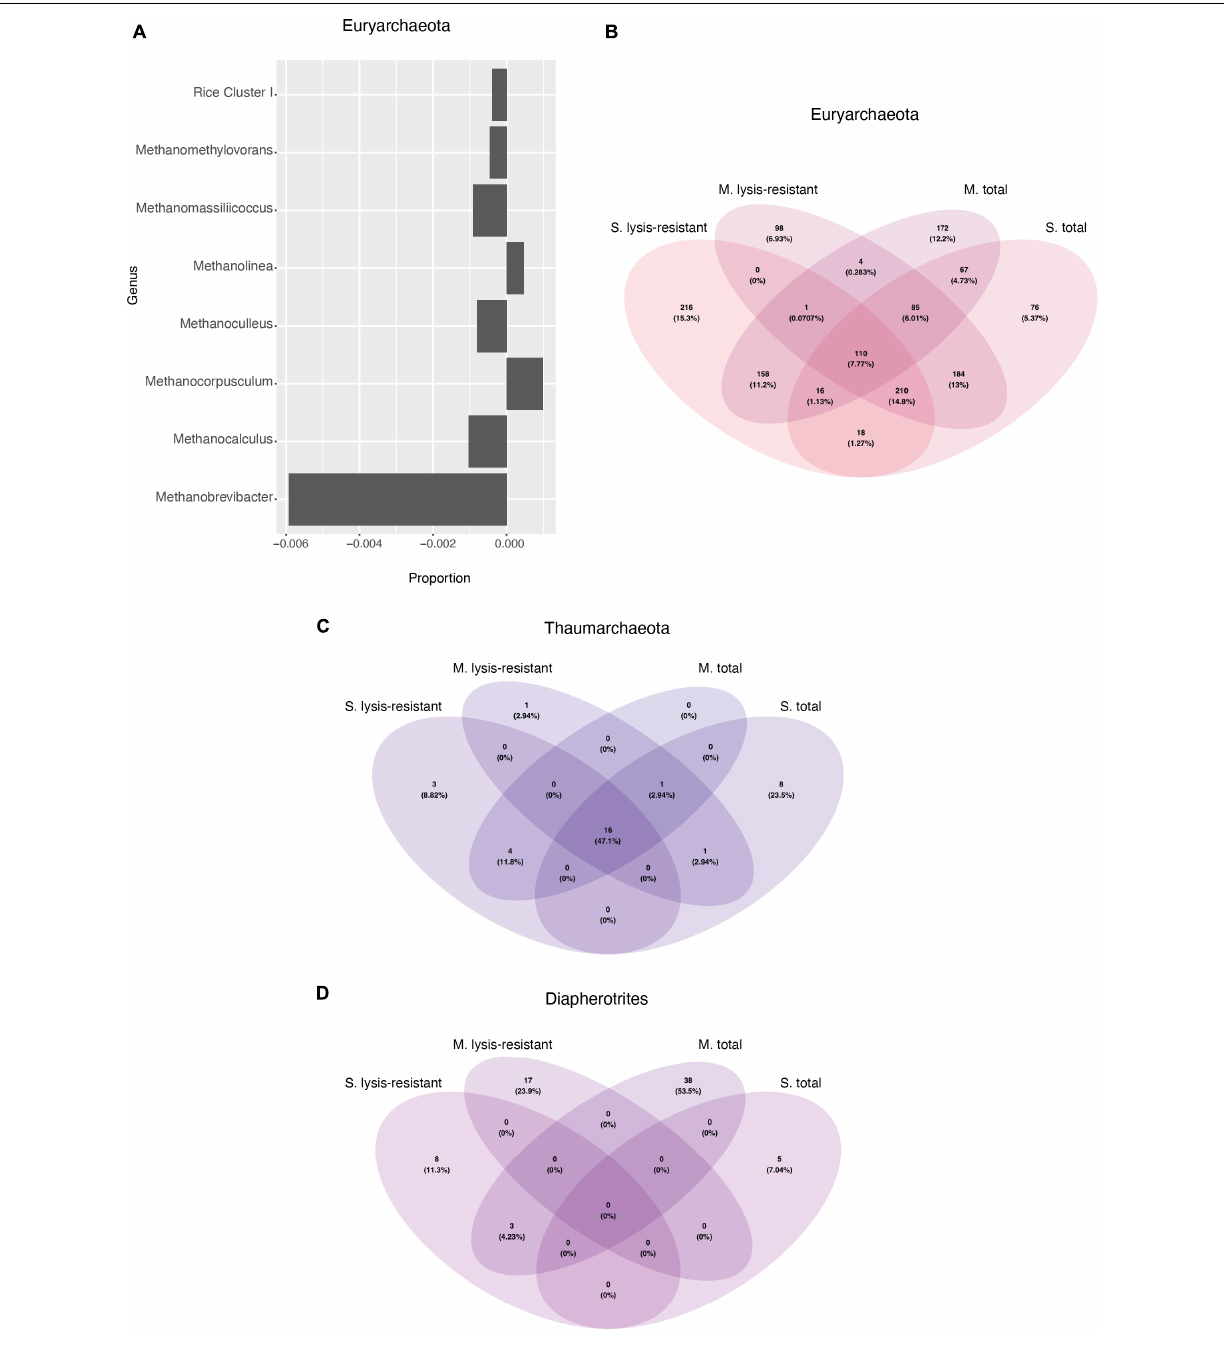
FIGURE 9 | (A) Enrichment of different Euryarchaeota genus in the lysis-resistant or total fraction in the microbial mats. Negative values show enrichment in the lysis-resistant fraction, while positive values show enrichment in the total fraction for each genus. Threshold at ≤ 0.00025 and > 0.00025. (B) Venn diagram of the Euryarchaeota in the 5,000 top ASVs for each fraction and environment. (C) Venn diagram of the Thaumarchaeota in the 5,000 top ASVs for each fraction and environment. (D) Venn diagram of the Diapherotrites in the 5,000 top ASVs for each fraction and